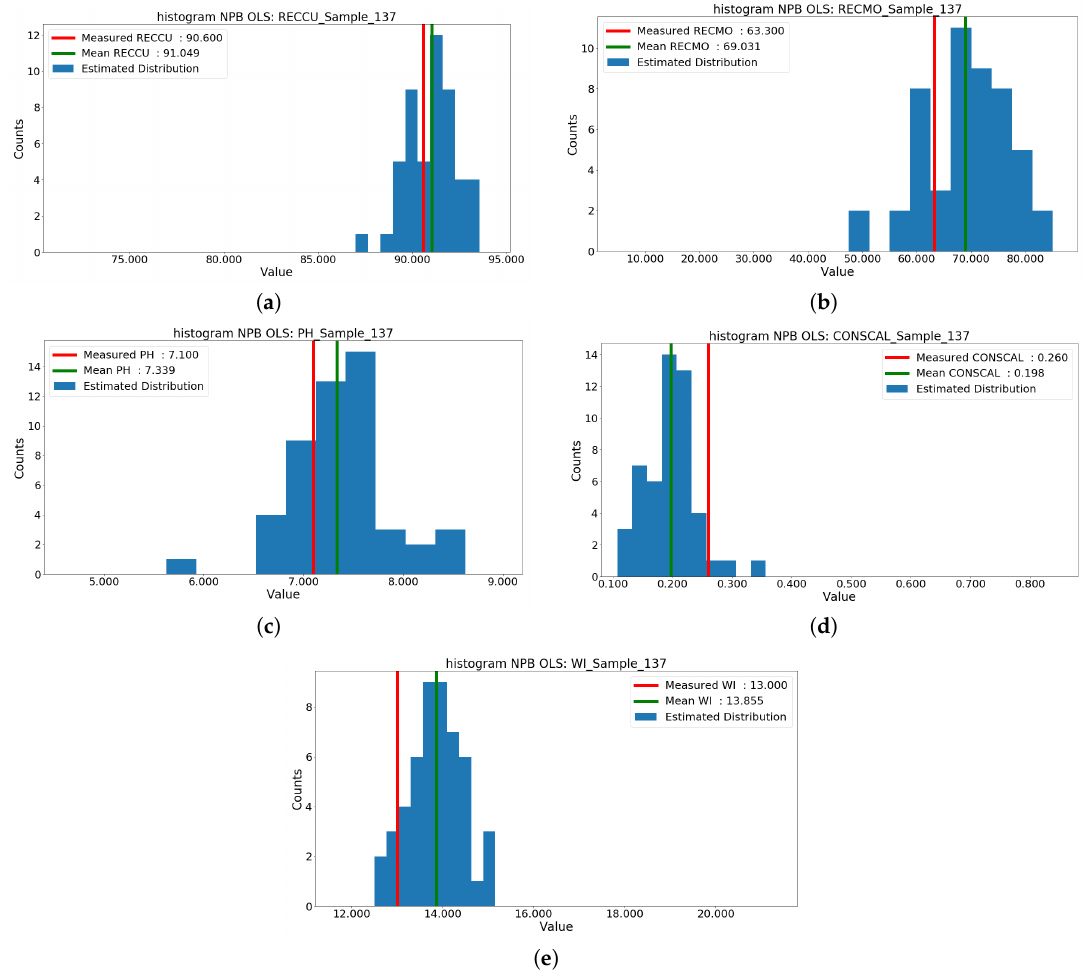
Figure 15. Distribution of the estimated geometallurgical variables for sample 137. Estimations for ( a ) recovery of copper, ( b ) recovery of molybdenum, ( c ) PH, ( d ) consumption of calcium carbonate and ( e ) bond working index.